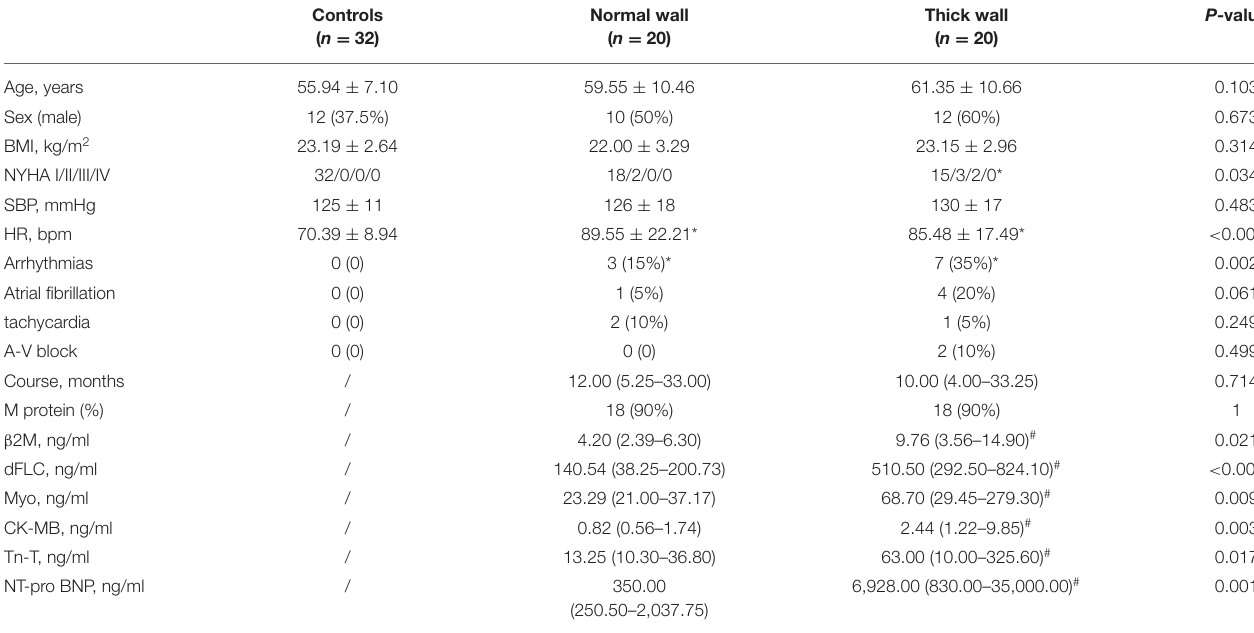
TABLE 1 | Characteristics of the study population.